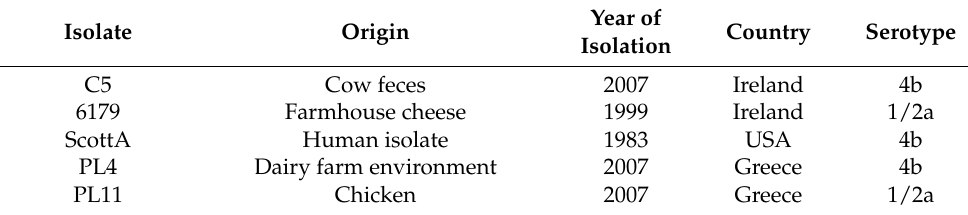
Table 2. Listeria monocytogenes strains used in the